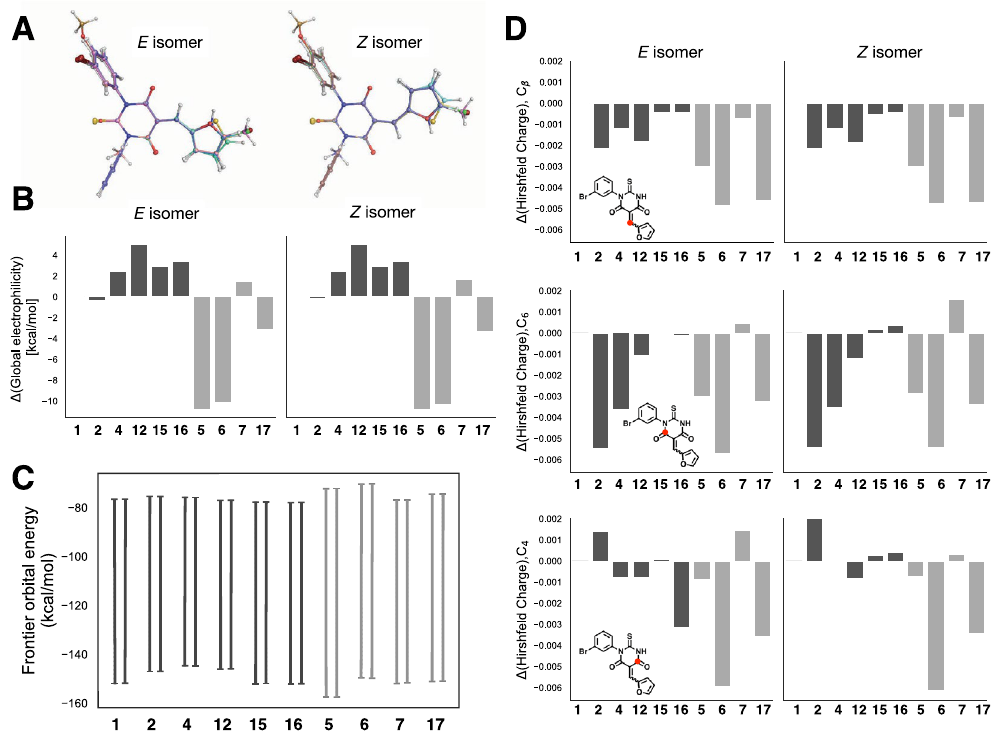
Figure 5. Computational analysis of SMIFH2 derivatives. ( A ) Optimized geometries of SMIFH2 (1) and nine analogs aligned in PyMOL based on the thiourea portion (N1-C2-N3) of each molecule. ( B ) Global electrophilicity plotted as a difference from SMIFH2. ( C ) Frontier orbital energy plotted showing the gap between the lower energy HOMO and higher energy LUMO. ( D ) Difference in Hirshfeld charges calculated for SMIFH2 carbons that are potential sites for nucleophilic addition. The specific carbons are indicated by a red dot in the structure exemplified for SMIFH2 ( 1 ). For panels ( B – D ), less active molecules are denoted with light gray bars and more active molecules are denoted with dark gray bars. All structures, energies, and charges were calculated with Gaussian (see Experimental Procedures for levels of theory and basis sets). See Figure S6 for raw electrophilicity and charge